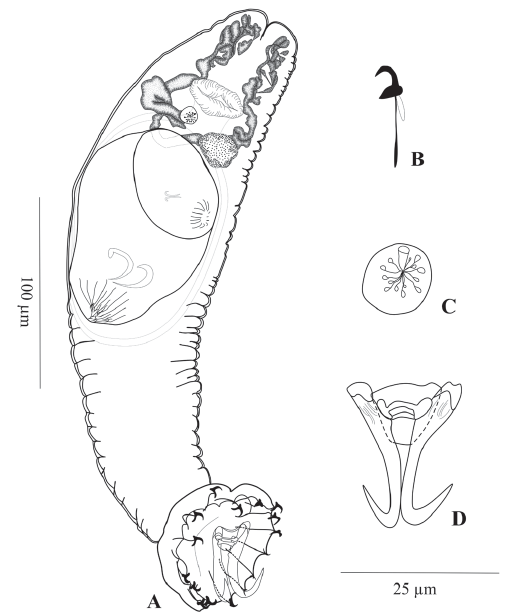
Figure 3. Gyrodactylus neotropicalis Kritsky & Fritts, 1970. (A) Composite drawing of whole-mount (ventral view); (B): Hook; (C) Copulatory organ (MCO); (D) Anchors, bars and shield on haptor; ventral